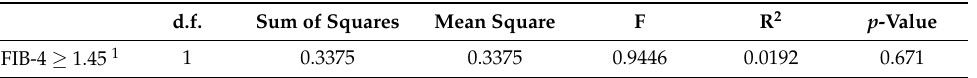
Table A1. Permutational multivariate analysis of variance (PERMANOVA) metagenomics analysis (UniFrac similarity).